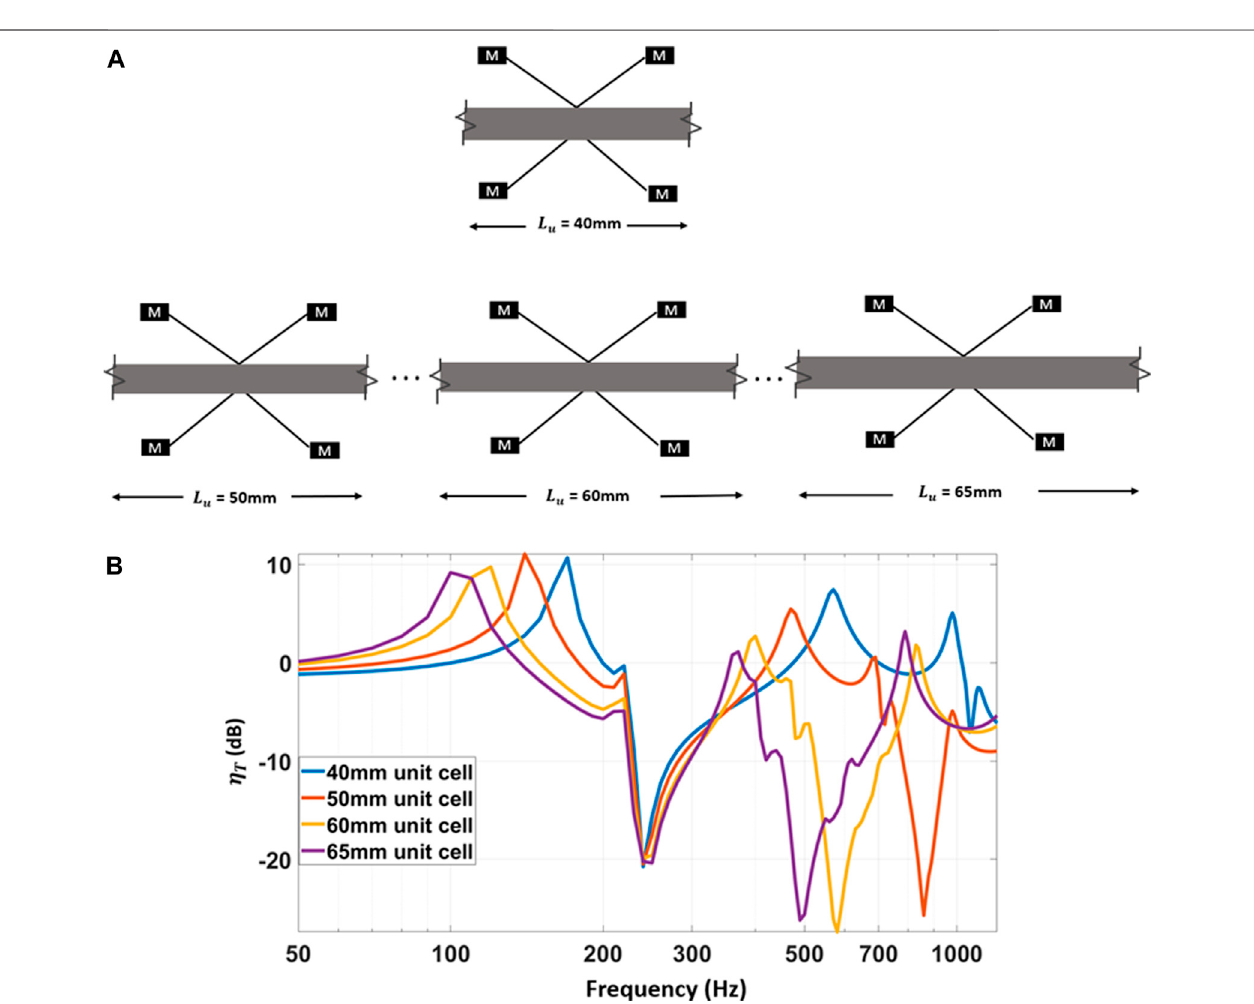
FIGURE12| Transmissibilitygraphsshowingtheeffectsofchangingthelengthofunitcellsonthe fi rstandsecondbandgapsofthelayeredmetamaterialstructure: (A) Graphical cartoon representation of changes in the length of the unit cell of the layered metamaterial structure. Note: the number of unit cells per horizontal beam remains the same ( α (cid:1) 3), but the totallength ofthehorizontal beam ischanged asthelength oftheunit cellisvaried, (B) theresults ofachangein lengthofunit cell, from 40 to 65 mm.